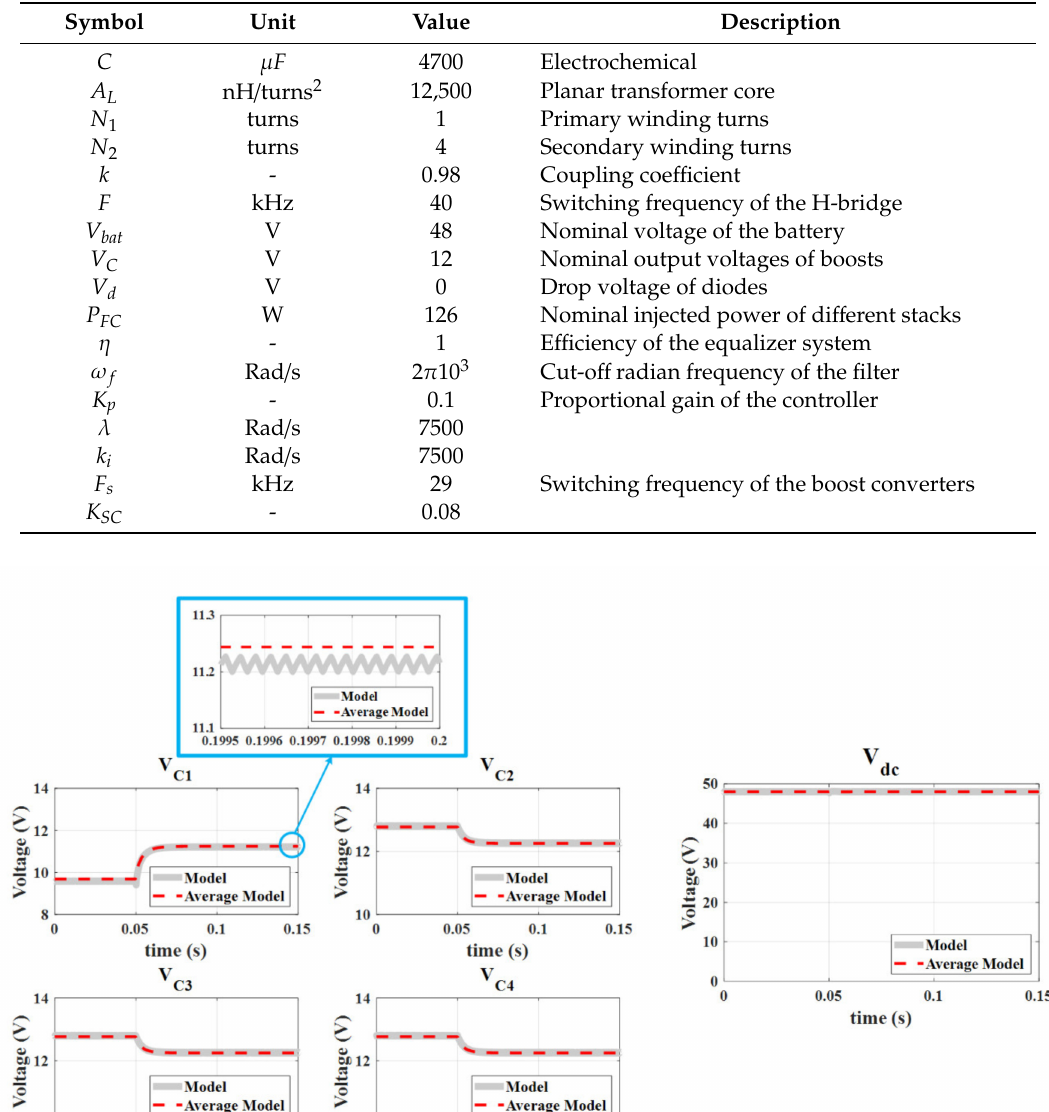
Table 1. Parameters of the proposed equalizer.